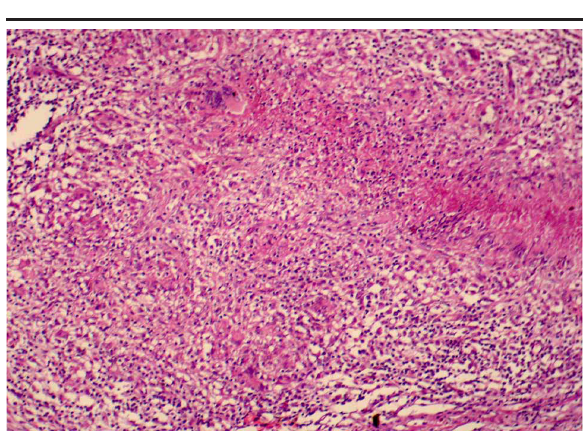
figure 2. Photomicrograph showing tuberculous salpingitis.Few granulomas and